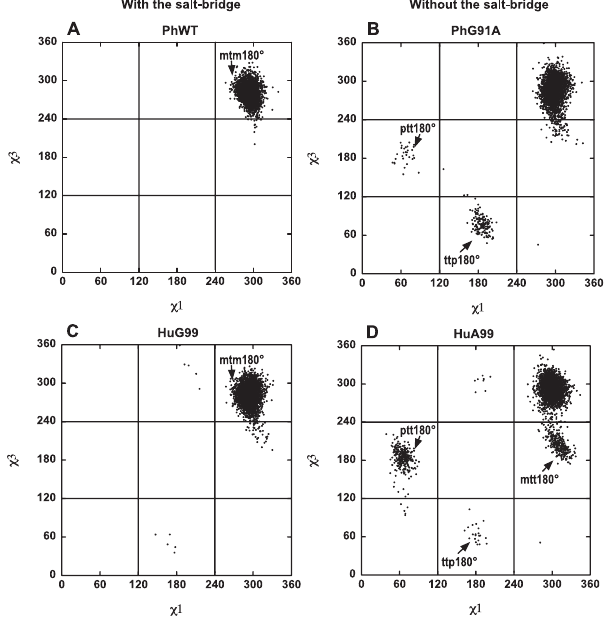
Substrate-analogue, S-benzyloxycarbonyl-thiosulfonate, was titrated to the variants of acylphosphatases to obtain values of association constant (K a ) and enthalpy ( D H b ) of binding at 298 K. Free energy ( D G b ) and entropy ( D S b ) of binding were calculated by: D G b = 2 RT ln K a and T D S b = D H b 2 D G b , where R is the universal gas constant. DD G b , DD H b , and DD S b represent the changes of these thermodynamic parameters upon the removal of the salt-bridge between the active-site arginine residue and the C-terminal carboxyl group.